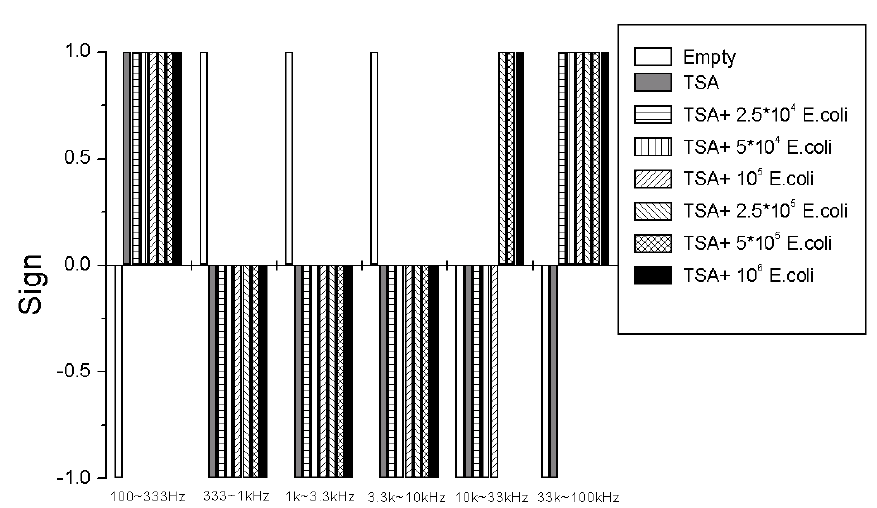
Figure 10. Variations of the binary pattern at different bacterium numbers. Bit B5 is not reliable therefore that bit should not be used for pattern recognition, see the Boolean logic in Section